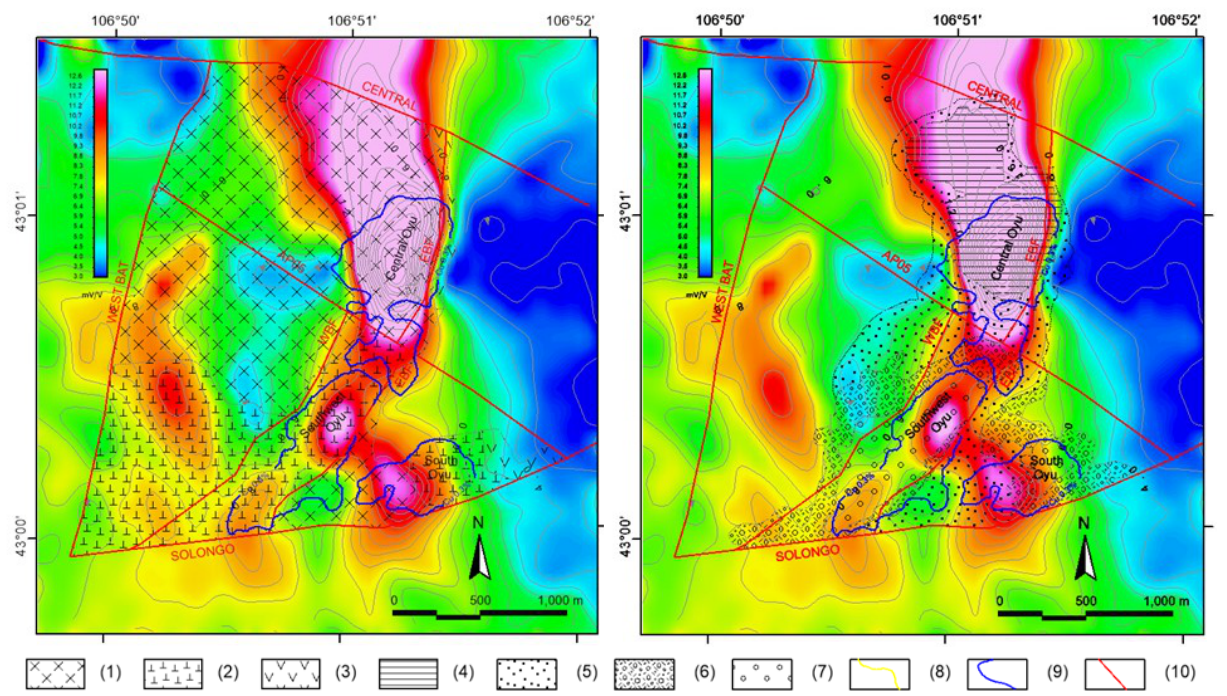
(1) Quartz-monzodiorite; (2) Augite Basalt; (3) Ignimbrite; (4) Advanced Argillic alteration zone; (5) Phyllic alteration zone; (6) Prophyllitic alteration zone; (7) Potassic alteration zone; (8) Gold grade isoline – 0.3 ppm; (9) Copper grade isoline – 0.3%; (10) Fig. 4. The Induced Polarization survey results (AB = 11000, MN=100): Chargeability overlapping with lithology (left), and Chargeability overlapping with alteration zones (right);